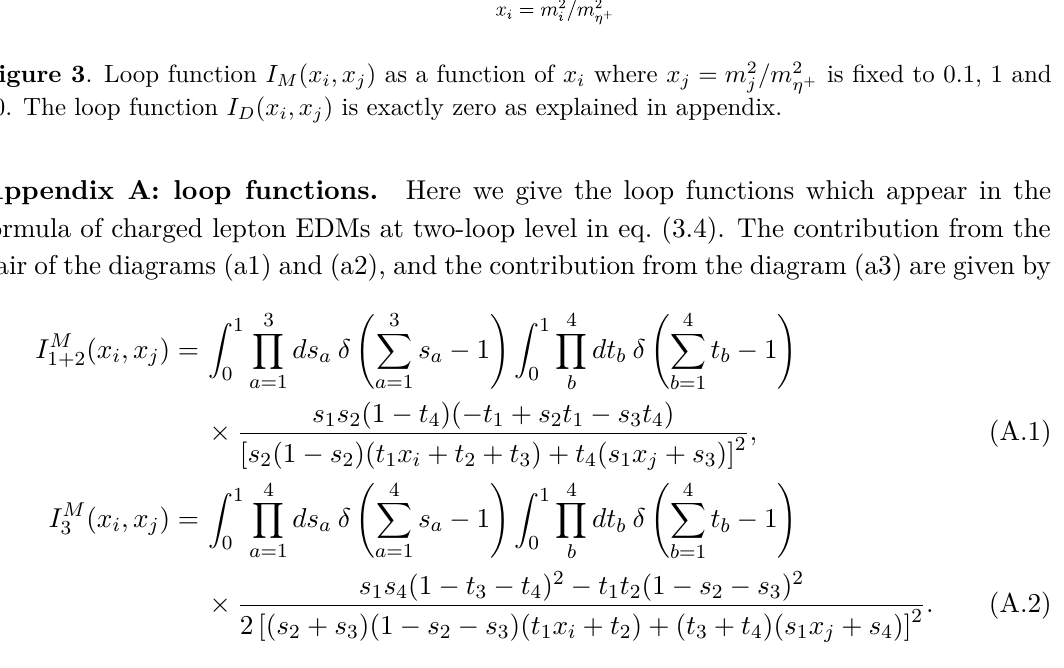
/m 2 is fixed to 0 . 1 , 1 and j η +